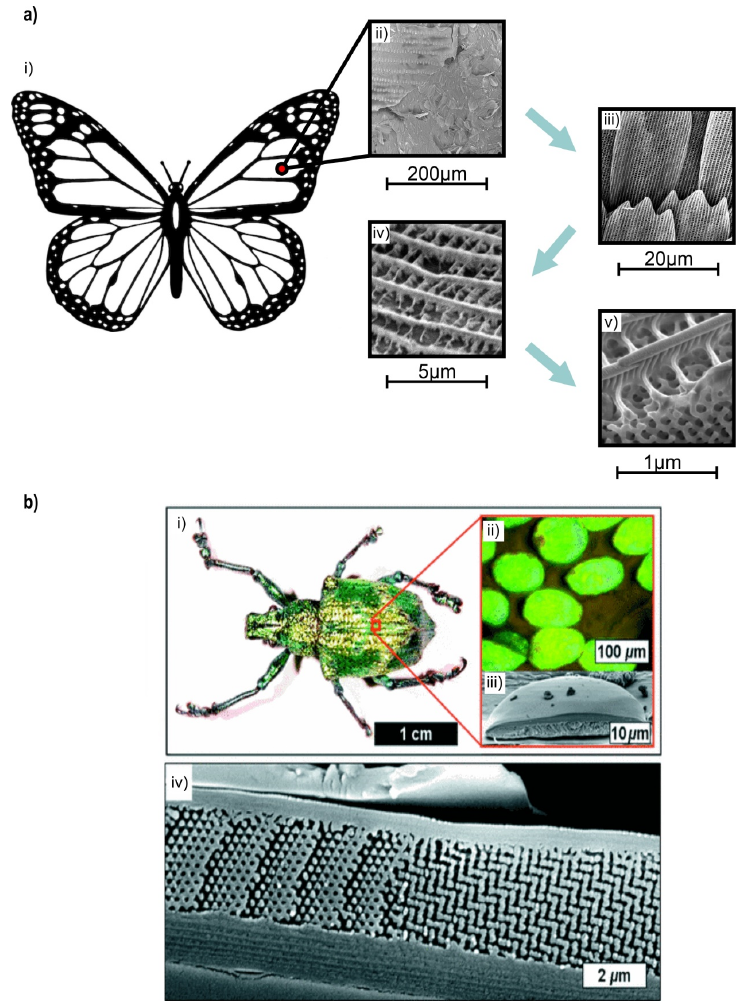
Figure 4. TPMS-like structures found in nature: ( a ) Gyroid in butterfly wings: (i)butterfly schematic was retrieved from [42]; (ii-v) SEM micrographs on a cross sectional view of a butterfly wing scale, where (v) was reproduced from [38]; ( b ) Schwarz Diamond in L. Augustus beetle shell (i) Photograph of the weevil L. Augustus. (ii) Optical micrograph of individual scales attached to the exoskeleton of L. Augustus under white-light illumination. (iii) Cross-sectional SEM image of a single scale. (iv) Detailed cross-sectional SEM image of a region of a scale. (Reproduced from [40], with permission of APS).